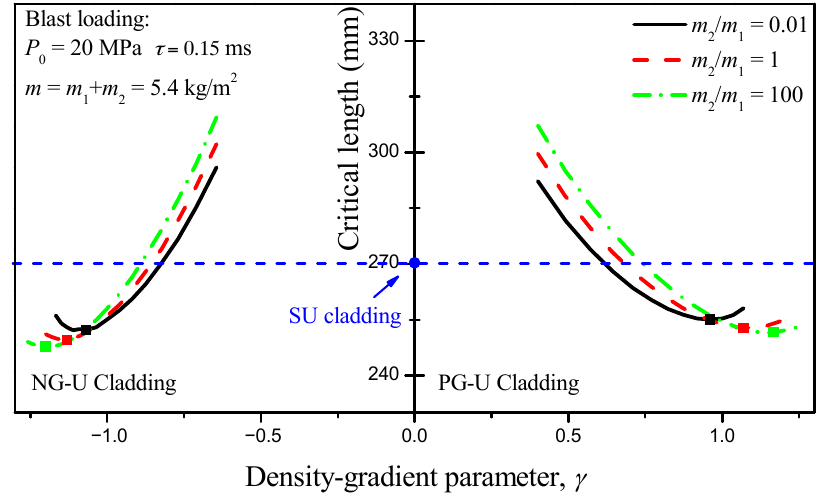
Figure 6. Variations of the critical length of the density graded-uniform cladding with gradient parameter γ .